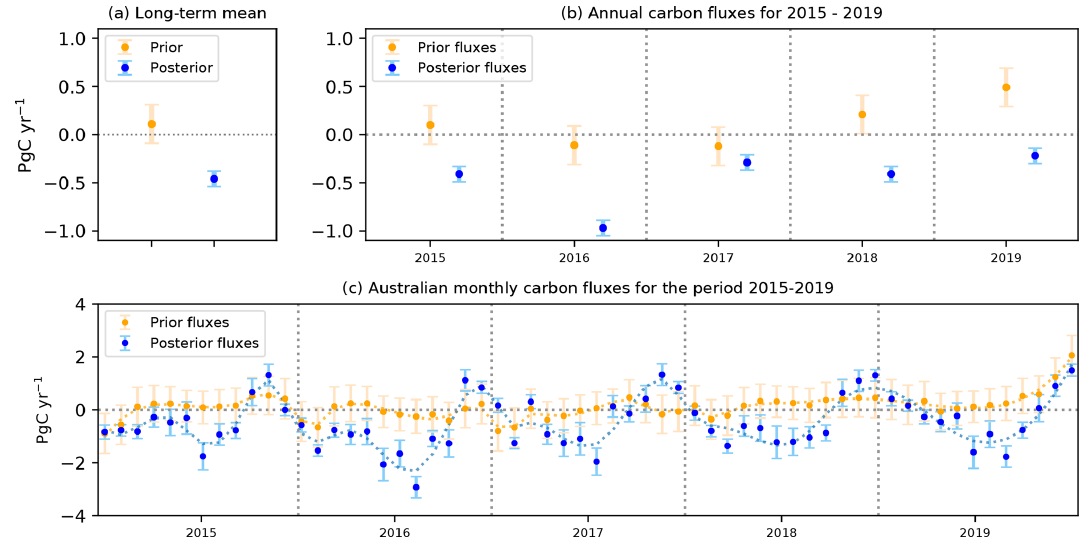
Figure 4. (a) Long-term mean carbon flux, (b) annual mean carbon flux, and (c) monthly mean prior (orange dots) and posterior (blue dots) carbon fluxes as well as their uncertainties (in PgCyr − 1 ) over Australia for the 2015–2019 period. Uncertainties in the prior and posterior fluxes are indicated by bars. The dashed orange and blue lines represent a smooth line for the prior and posterior fluxes respectively. Within these estimates, we only included the terrestrial part of the Australian carbon cycle, including fires but not fossil fuel